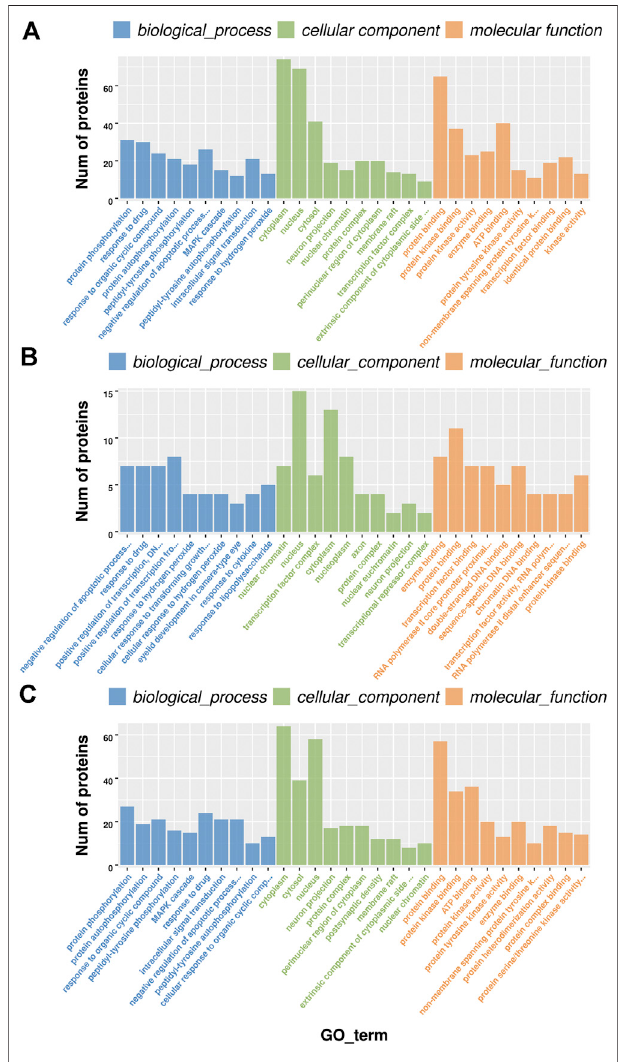
FIGURE 4 | GO analysis of DEPs co-regulated by both BCP modeling and EAtreatmentin rat DRGs. (A) The top 10signi fi cant biological processes, molecular functions, and cellular components of DEPs shared by both the BCP and BCP + EA groups; (B) the top 10 signi fi cant biological processes, molecular functions, and cellular components of DEPs upregulated in the BCP group but further downregulated by EA intervention in theBCP+EAgroup; (C) thetop10signi fi cantbiologicalprocesses,molecular functions, and cellular components of DEPs downregulated in the BCP group but further upregulated by EA intervention in the BCP + EA group; the signi fi cant p -value was 0.05. GO: gene ontology; DEPs: differentially expressed phosphorylated